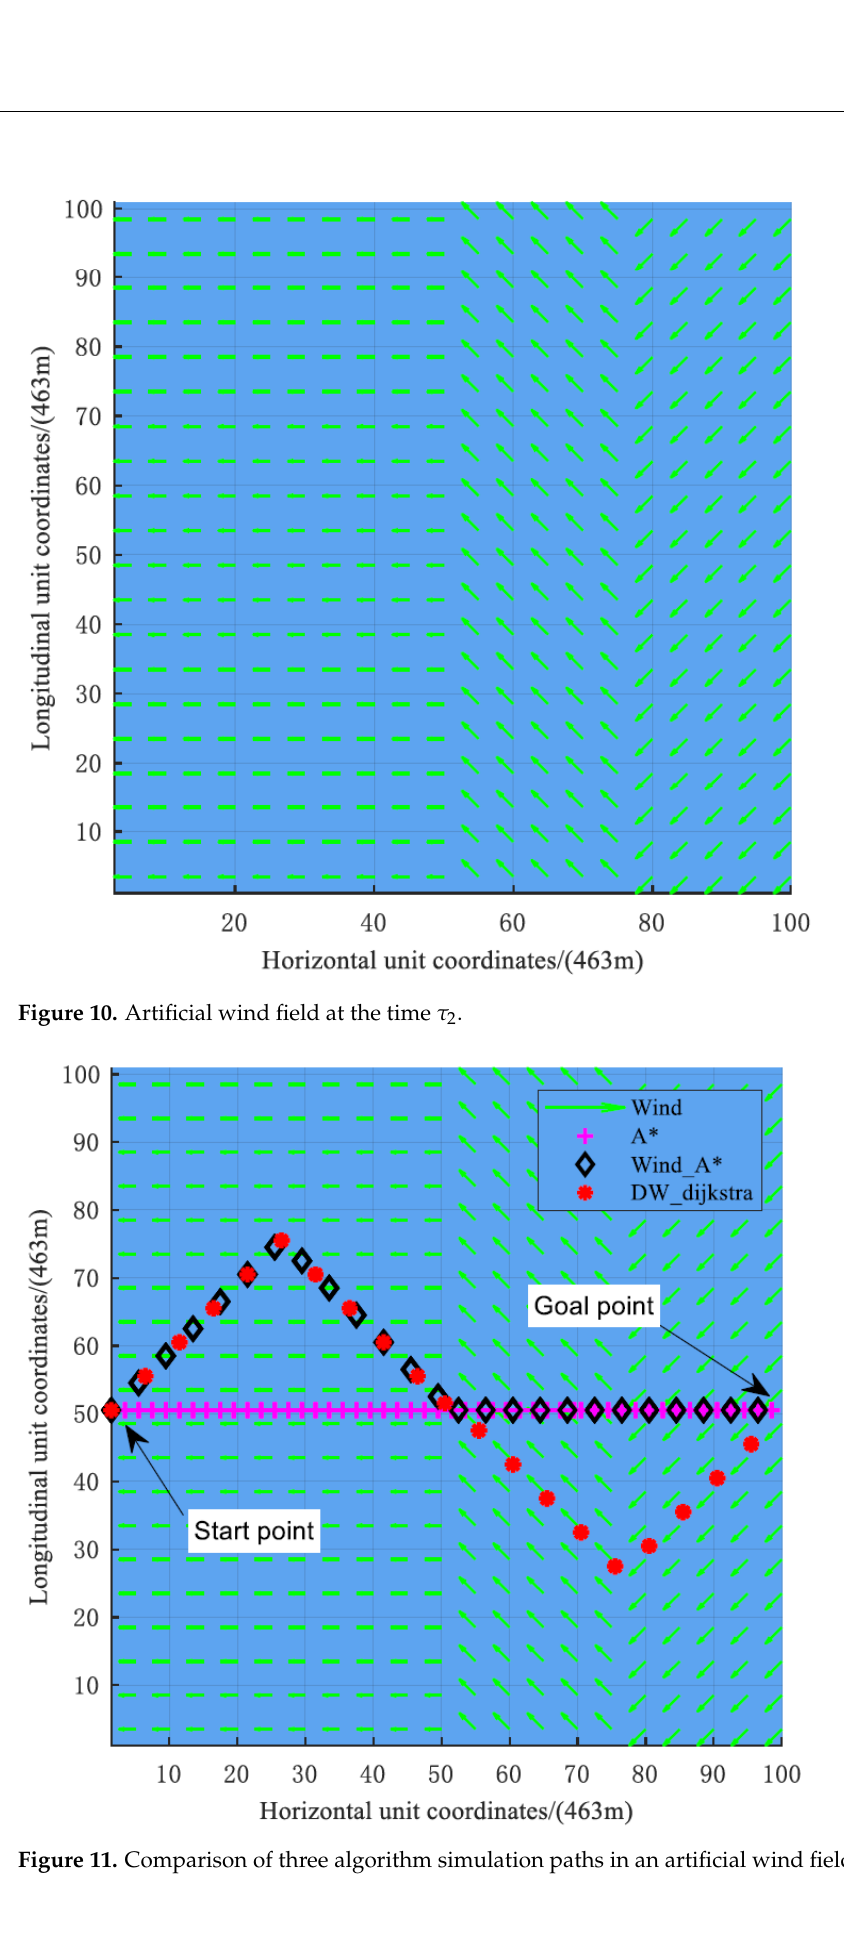
Figure 11. Comparison of three algorithm simulation paths in an artificial wind field.